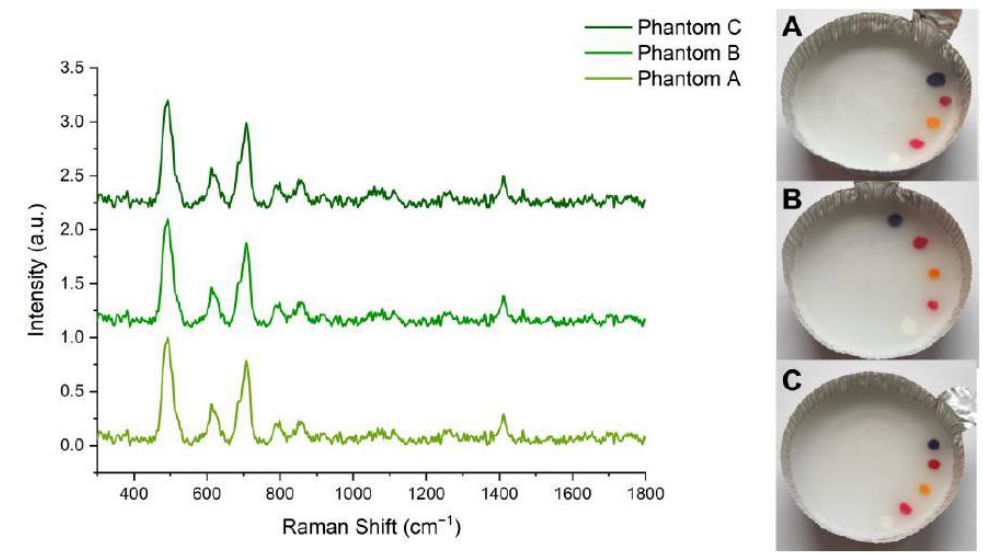
Figure 2. Normalized and baseline-corrected Raman spectra of pure Phantoms A, B, and C ( on left ). Dots tattooed with Inks 1 – 5 on Phantoms A, B, and C ( on right ).